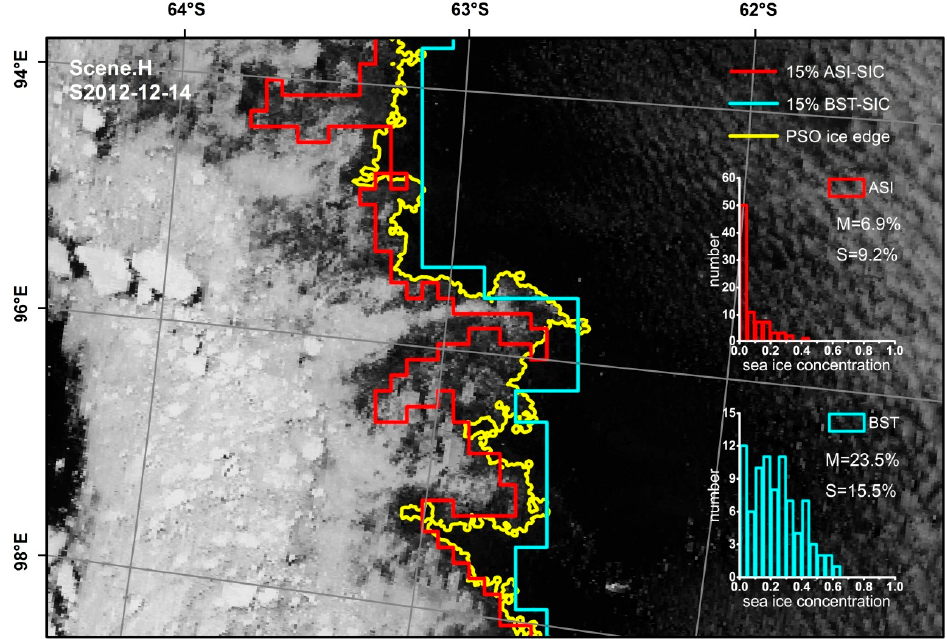
Figure 4. The contour of the 15% ASI ‐ SIC, 15% BST ‐ SIC and the PSO ice edge overlaid on the MOD09GA, for the Antarctic on 14 December 2014.